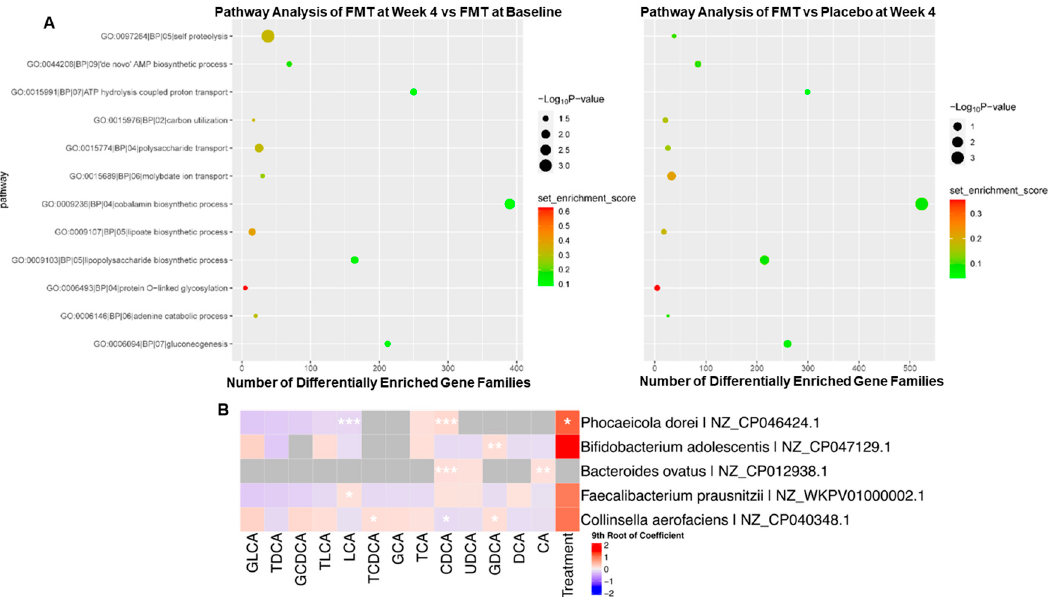
Figure 3. Association between bile acids and bacterial species. ( A ) Assessment of pathways enriched by FMT relative to baseline ( left ) and relative to placebo control after 4 weeks of treatment ( right ). ( B ) Bacterial species and strains that are correlated with gut bacterial-derived bile acids. * p < 0.2, ** p < 0.05, *** p < 0.001.